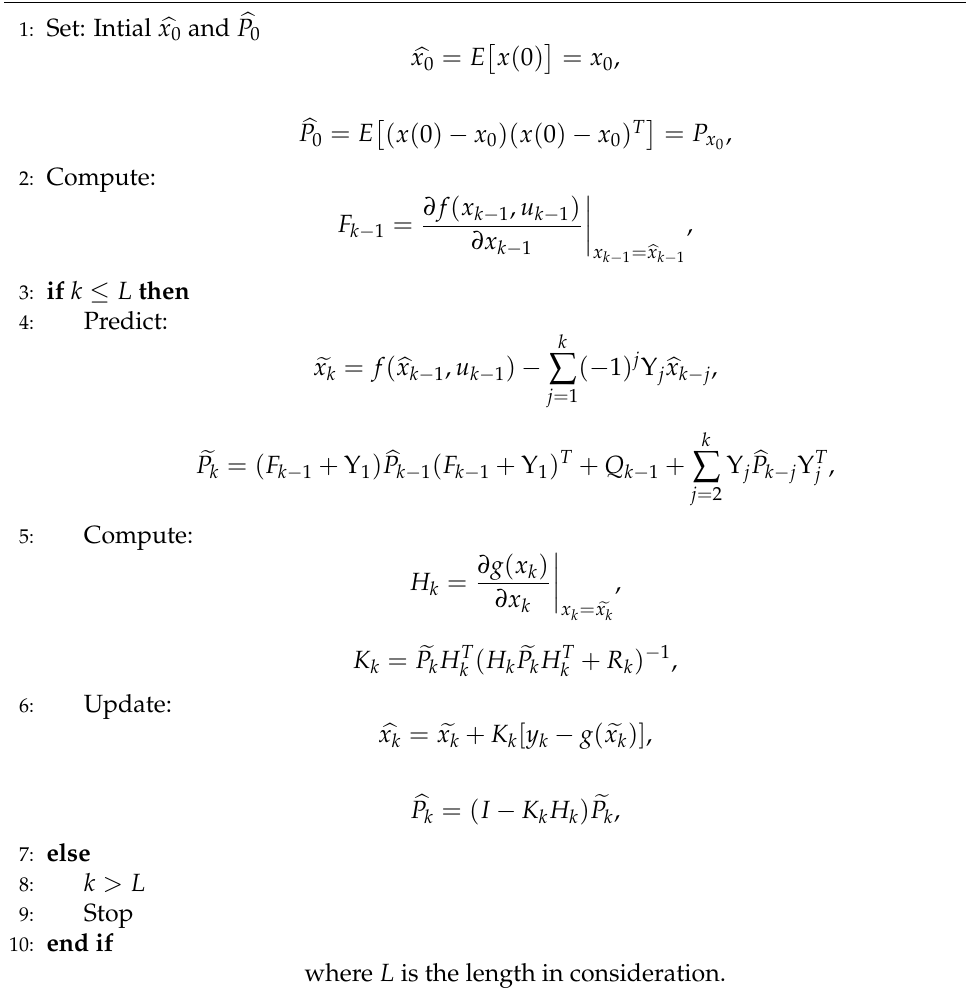
Algorithm 1 Standard extended Kalman filtering